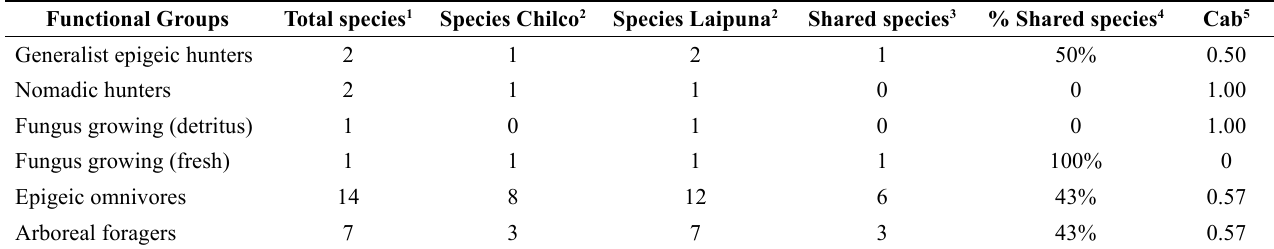
Table 4. Functional group diversity. 1- Total species for each group, 2- Species found only in each site, 3- Species shared amongst sites, 4- percentage of shared species, 5- Functional group complementarity values between each